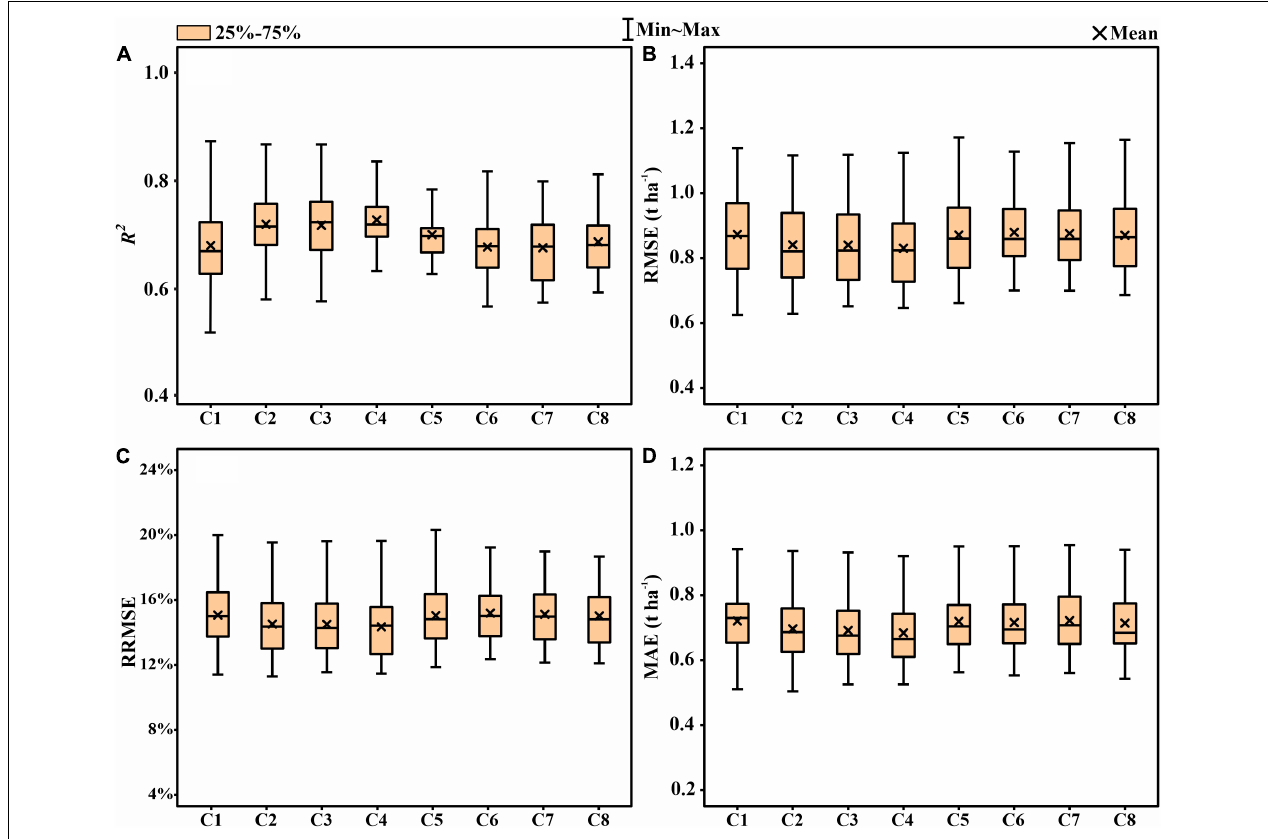
FIGURE 9 | Statistical distributions of (A) R 2 , (B) RMSE, (C) RRMSE, and (D) MAE of the entropy weight fusion (EWF) method for GY prediction in the test phases.